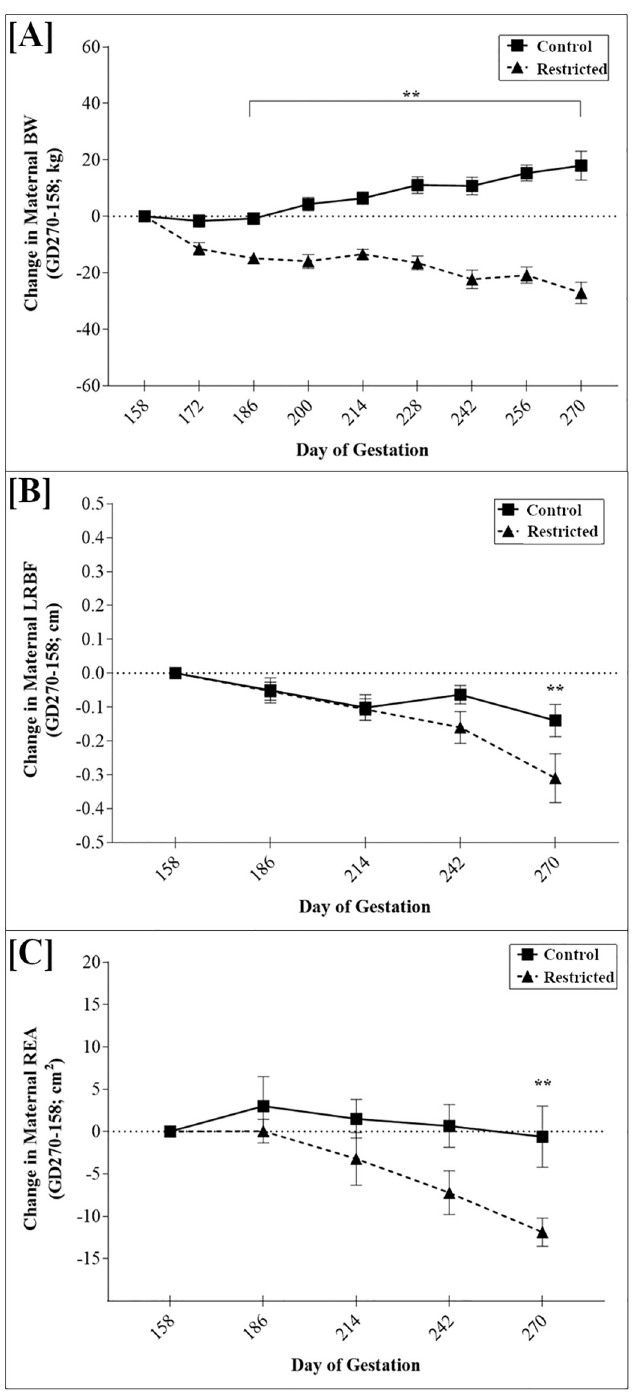
Fig 1. Effects of feeding 100% NRC (control; n = 9) or 70% NRC (restricted; n = 9) energy requirements to pregnant beef heifers from gestational day 158 to parturition on maternal [A] net body weight (BW; �� P < 0.01), [B] last rib back fat (LRBF; �� P < 0. 01), and [C] ribeye area (REA; �� P < 0. 01).